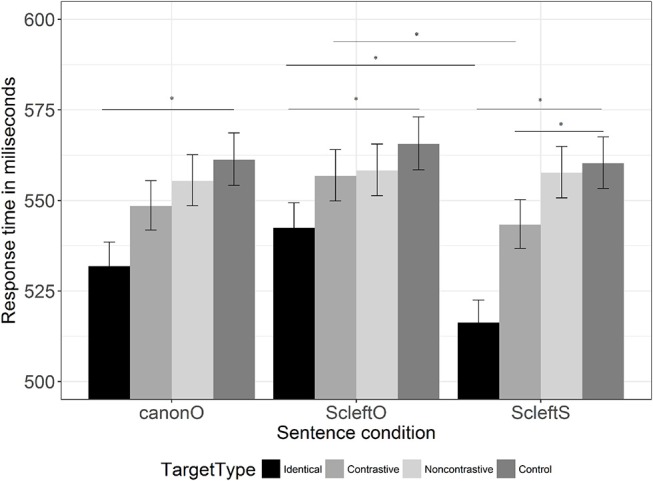
Back-transformed fitted RTs in ms to four target types in canonO, ScleftO, and ScleftS conditions. Error bars show standard error of the means. Stars (*) show significant comparisons (p < 0.05).